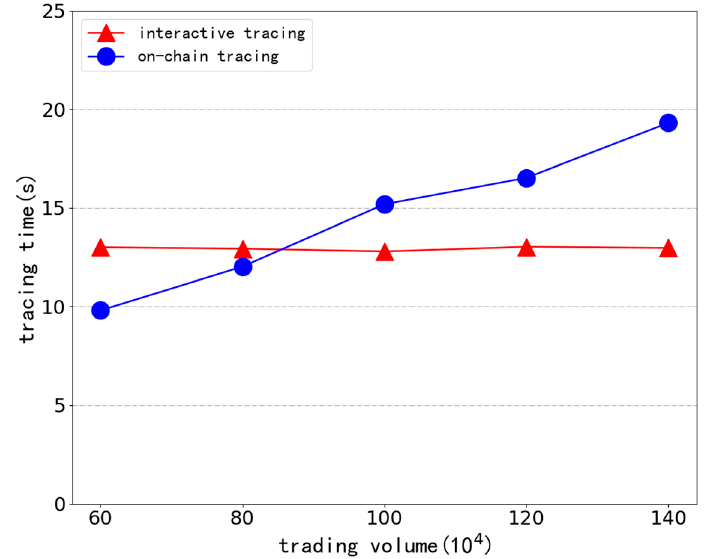
Figure 9. When the transaction chain span is too short, the traceability efficiency is lower than that of the traditional method.